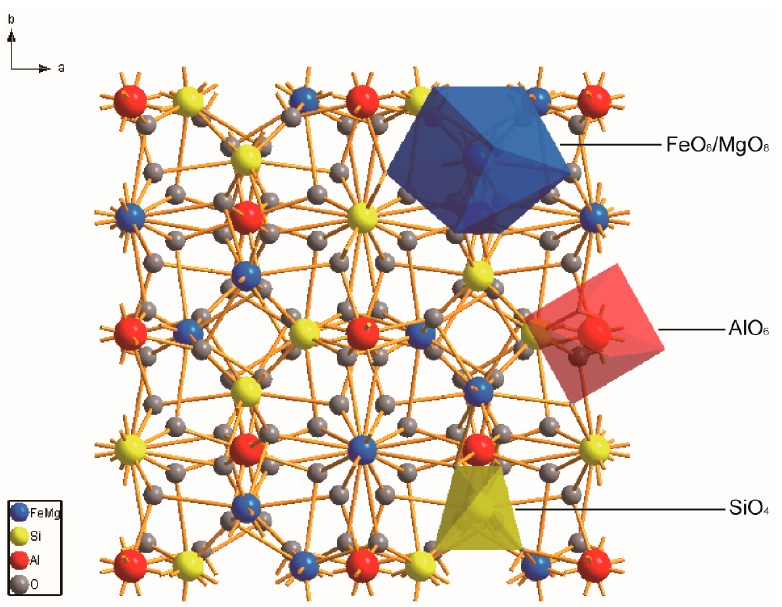
Figure 1. Crystal structure of garnet at ambient conditions.